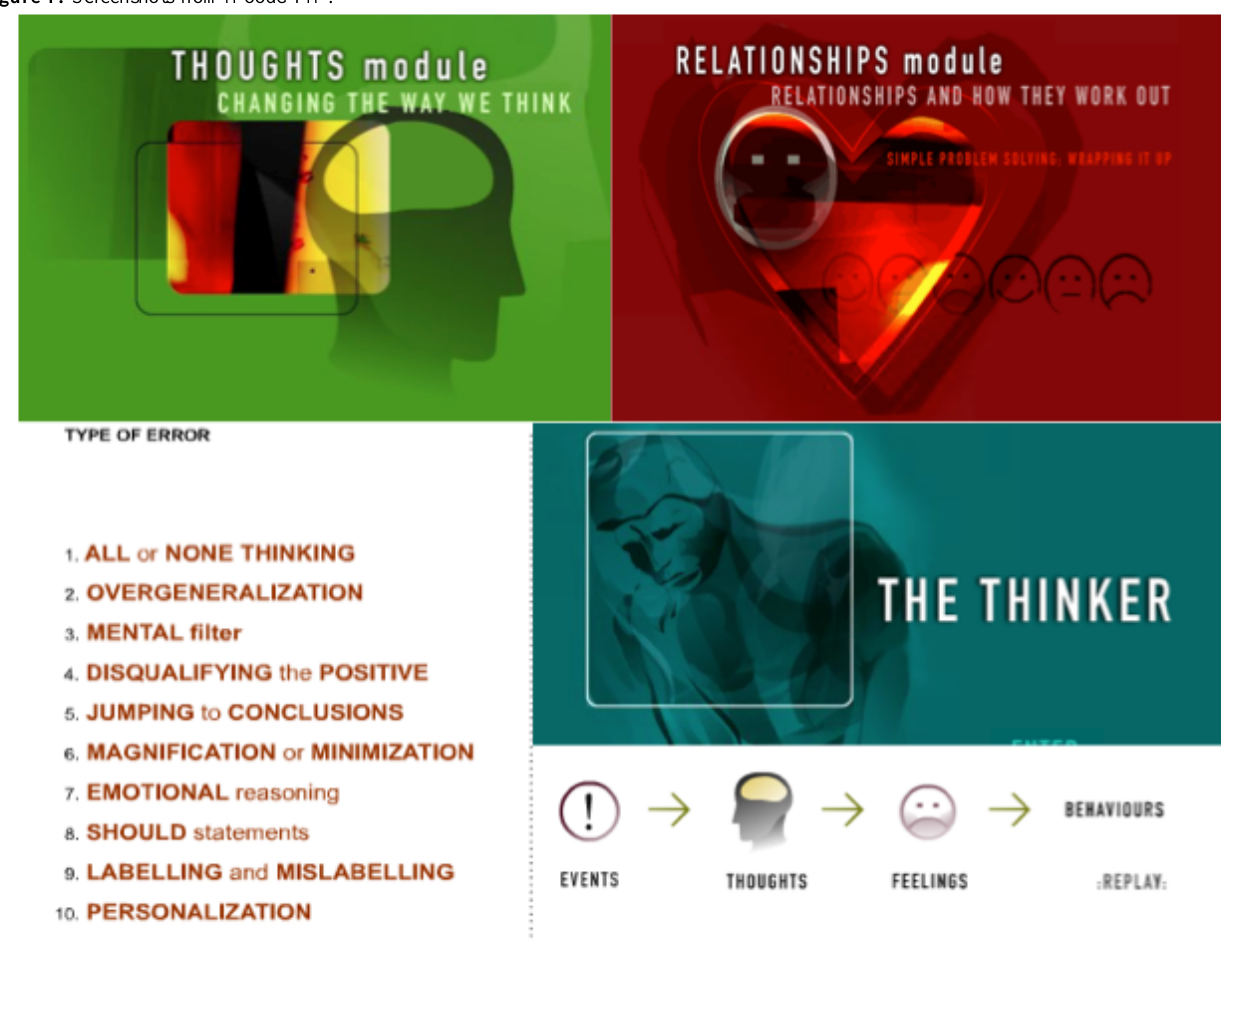
Figure 1. Screenshots from